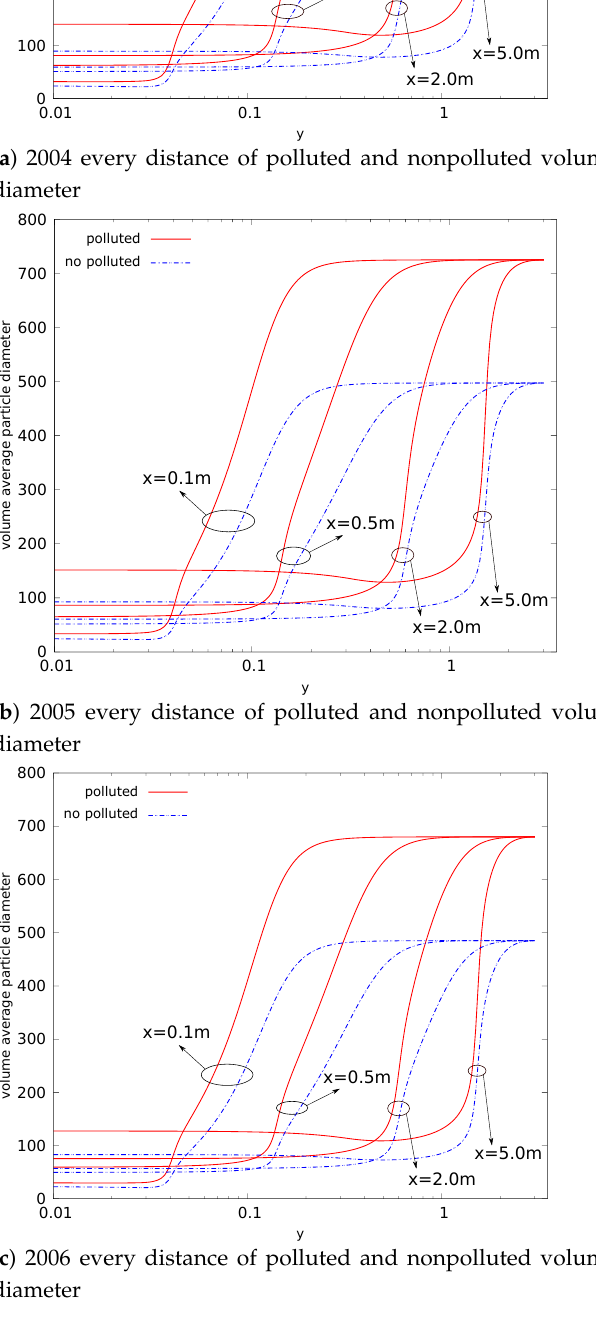
Figure 5. Status of volume average particle diameter over three different